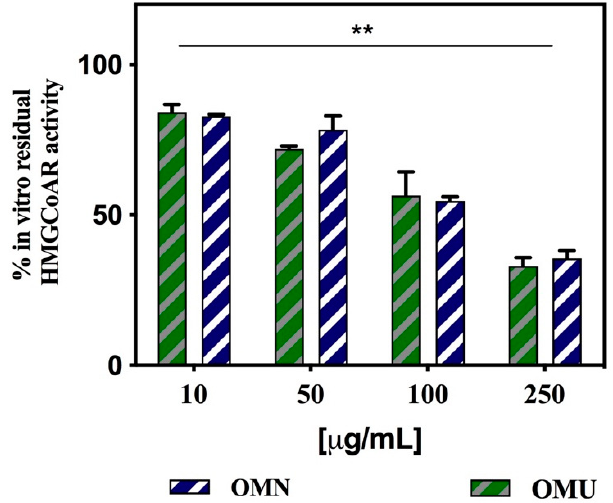
Figure 5. Effect of OMN and OMU extracts on the in vitro activity of HMGCoAR. Data represent the mean ± s.d. of three determinations performed in triplicate. All the data sets were analyzed by two-way ANOVA. In particular, the reduction of enzyme activity is significant as function of the all the tested concentrations (**) p < 0.01, whereas no significant difference was observed between OMN and OMU extracts.